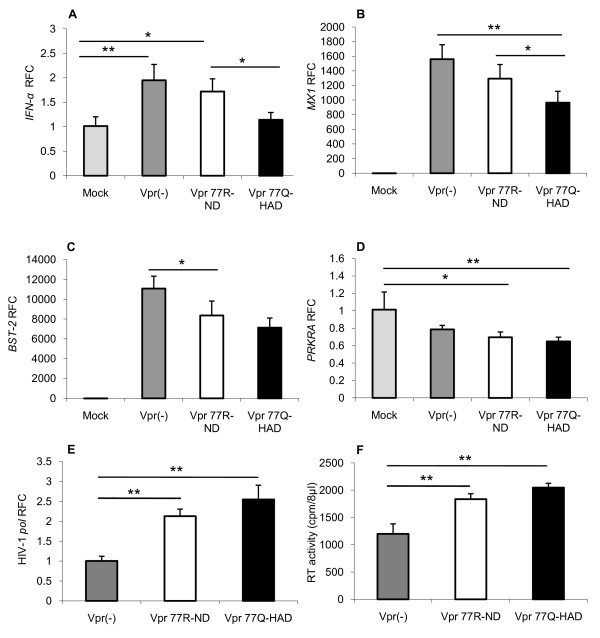
Human astrocyte transfection with HIV-1 Vpr mutant viruses. (A) Transduced astrocytes showed that pseudotyped virus (pv) expressing Vpr77Q induced the least IFN-α expression. Similarly, the Vpr77Q virus induced (B) MX1 and (C) BST-2 transcript levels were lowest in the Vpr77Q virus-transduced astrocytes; while (D) PRKRA was consistently reduced by all HIV-1 vectors. (E) In contrast to the host gene expression observed in A, B and C, HIV-1 pol were highest in the Vpr77Q virus-transduced astrocytes, which was complemented by a similar profile in RT activity in matched supernatants (F). Experiments were carried out in triplicate at least two times (A-F, Dunnett test, relative to control; *p < 0.05, **p < 0.01).